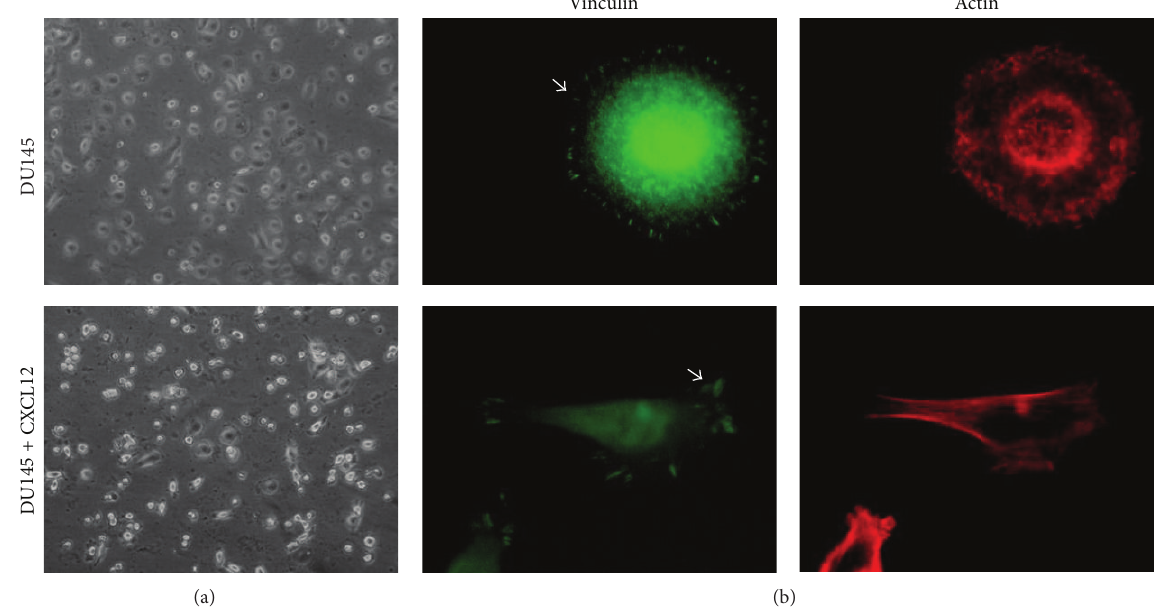
Figure 3: CXCL12 induces focal adhesion disassembly, actin stress fiber rearrangement, and morphological change in DU145 cells seeded on FN. Cells were incubated for 2hrs, fixed, and double-stained for vinculin and actin. Arrows in the images indicate localization of vinculin at the end of actin bundles in focal adhesion complexes.